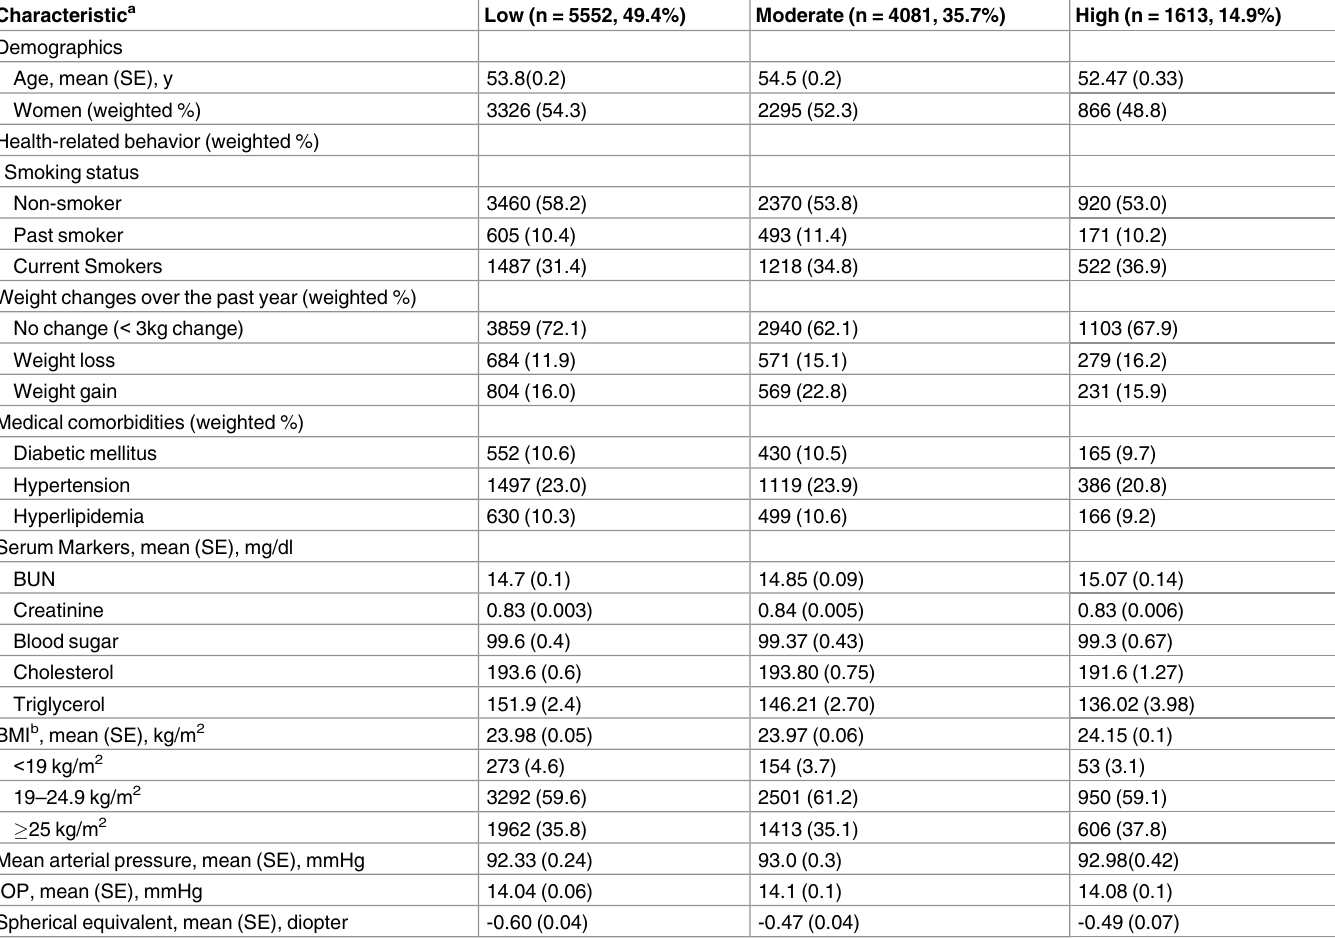
Table 3. Demographic and general health characteristics of participants in low, moderate and high physical activity intensities. Characteristic a